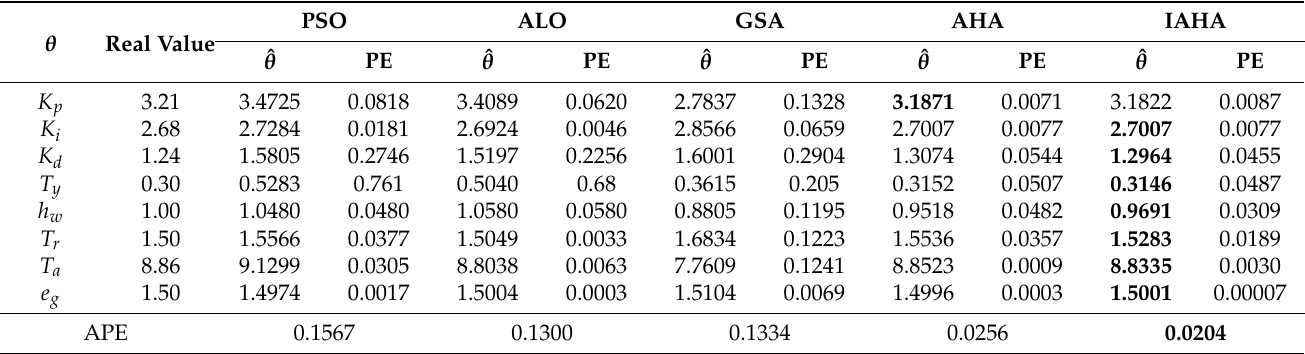
Table 5. Algorithm identification results of 5% frequency disturbance.